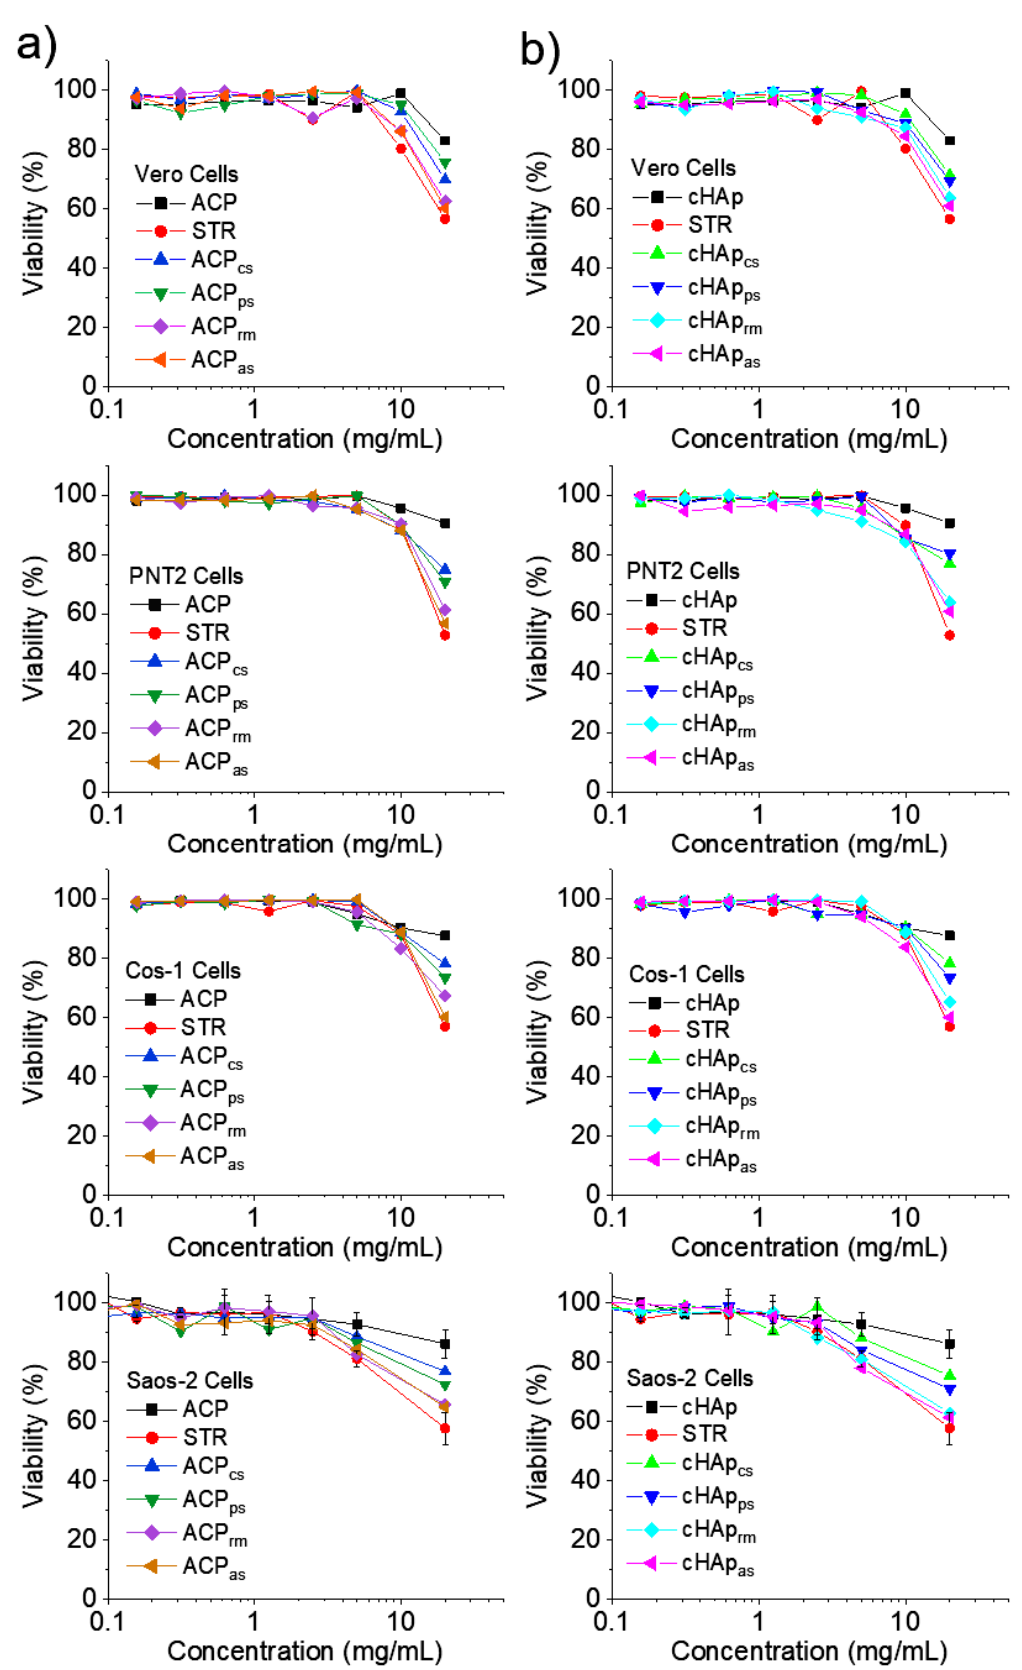
Figure 8. Cytotoxicity curves for ACP ( a ) and cHAp ( b ) nanoparticles.